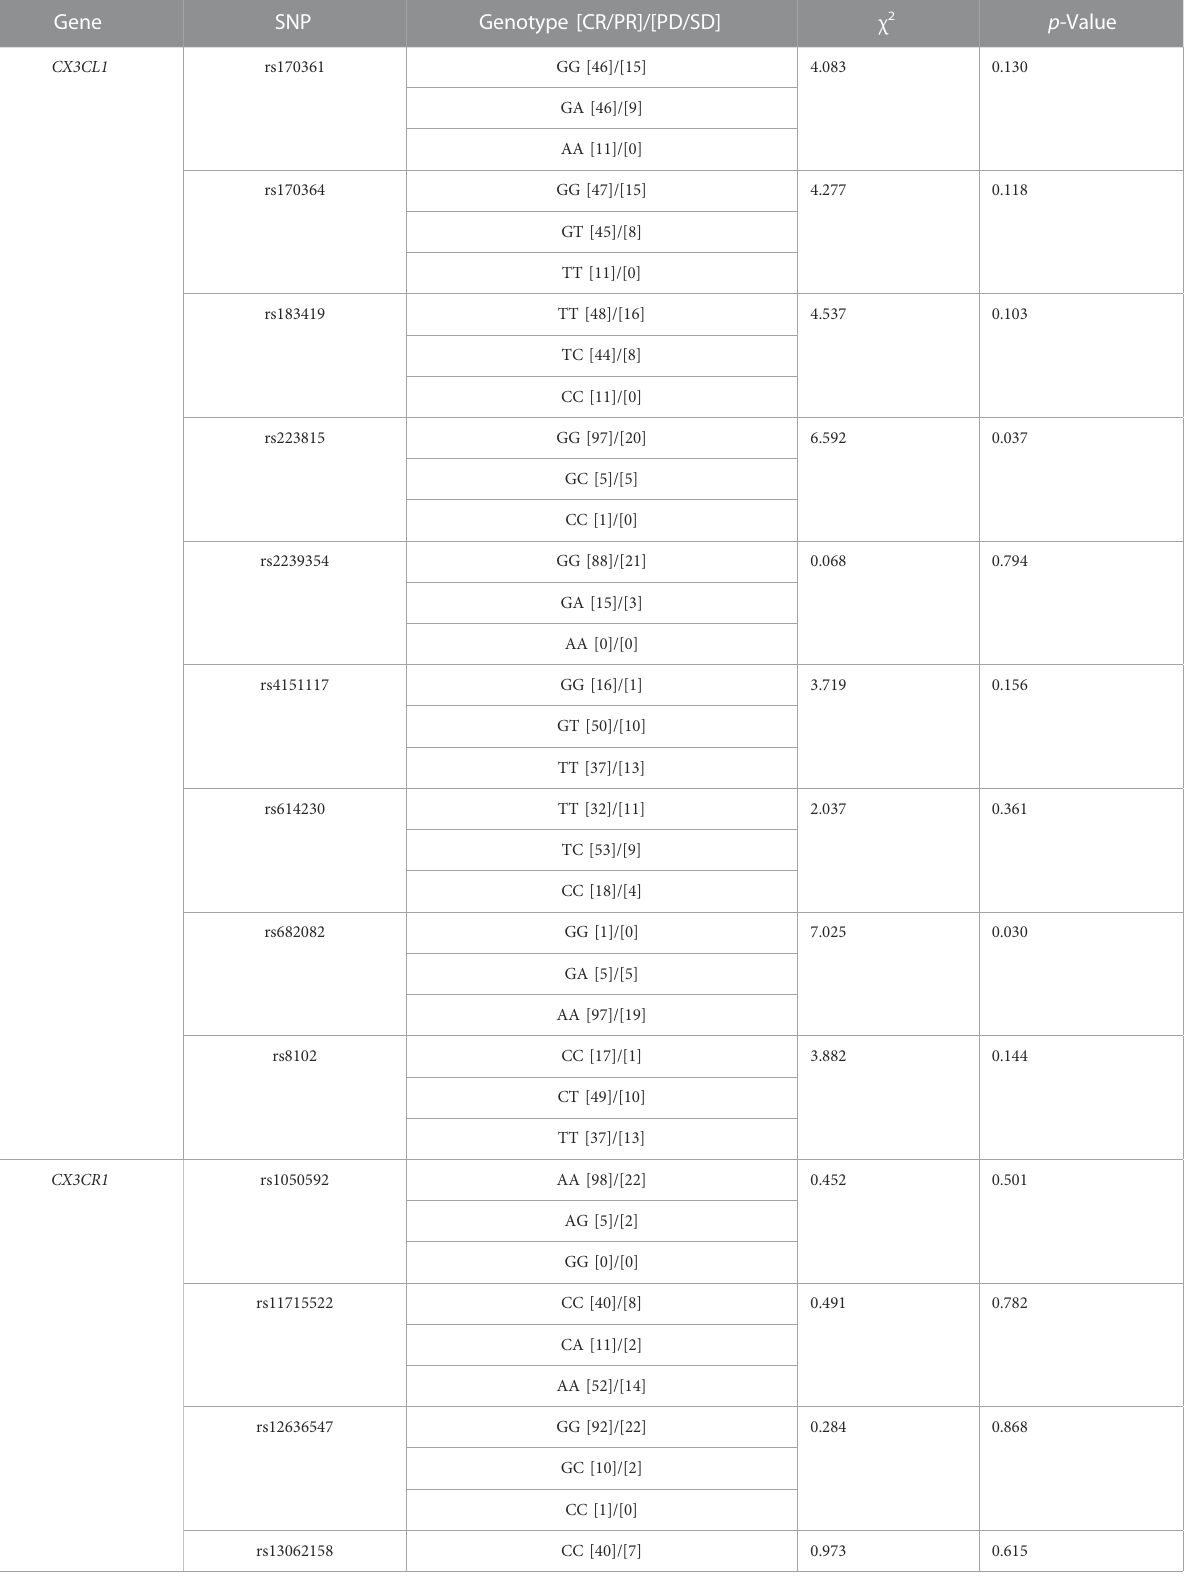
TABLE 3 Association of CX3CL1 and CX3CR1 SNPs with the clinical ef fi cacy of carboplatin treatment in ovarian cancer patients.